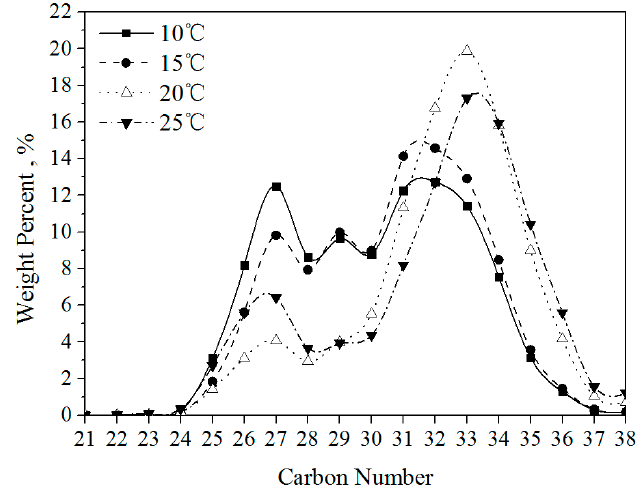
Figure 8. The carbon number distribution of precipitated wax at 25 °C, 20 °C, 15 °C and 10 °C for 10% artificial oil.